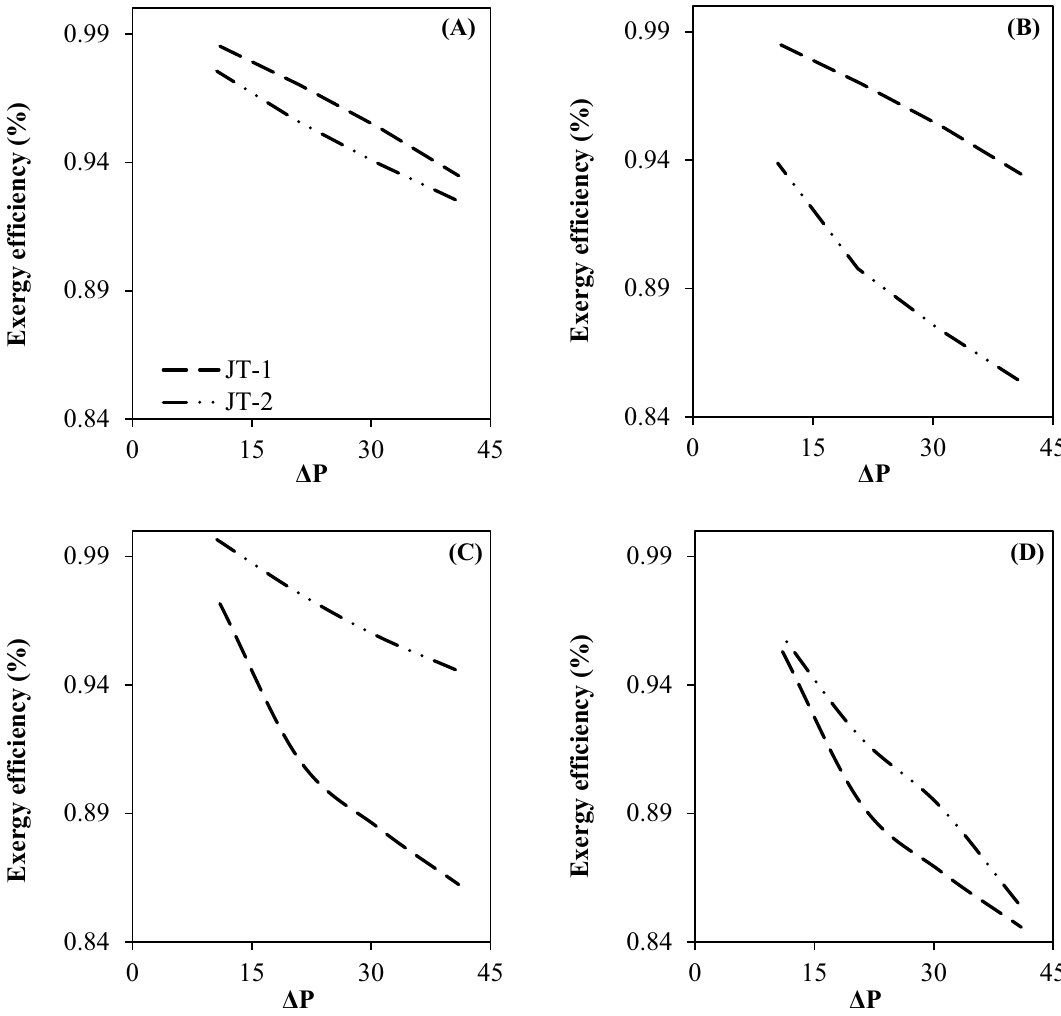
Figure 15. Exergy efficiency for various investigated configuration as function of pressure gradient: ( A ) configuration ( A, B ) configuration ( B, C ) configuration ( C and D ) configuration ( D